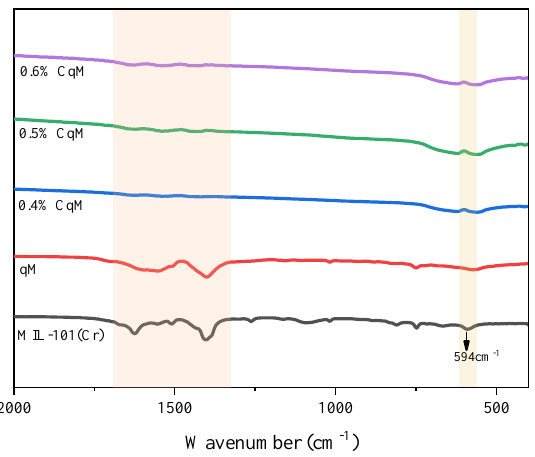
Figure 2. X-ray diffraction patterns of various catalysts.